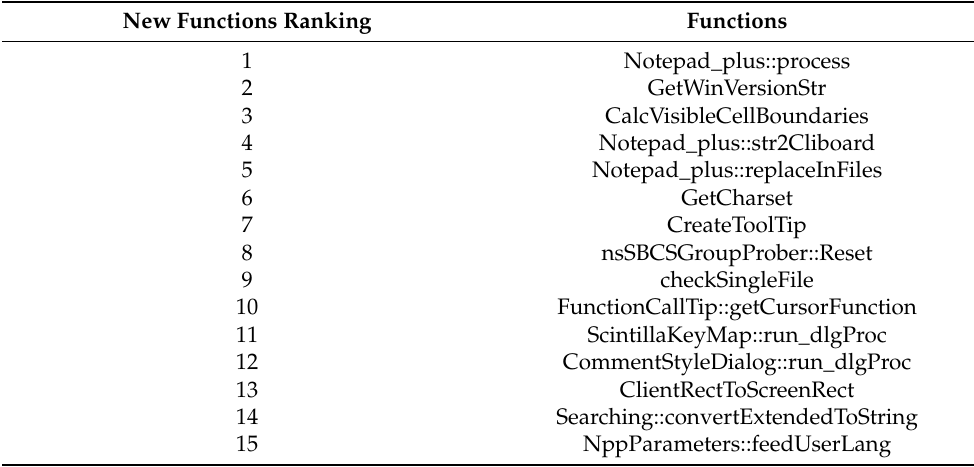
Table 5. The part of 378 functions ranking calculated by the DEA